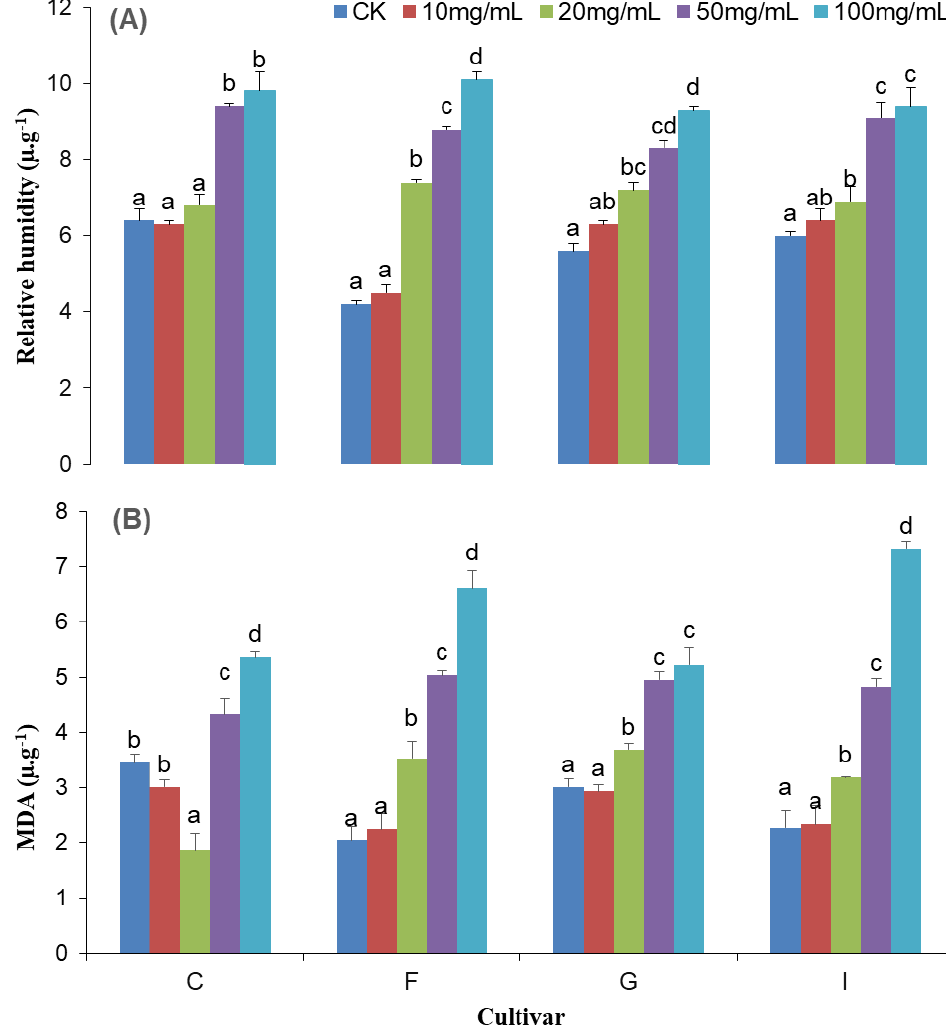
Figure 1. Relative conductivity ( A ) and MDA contents ( B ) of chrysanthemum cultivars subjected to different Cd concentrations. Each value represents the mean ± S.E from the three independent replicates (±, n = 3), and different statistical letters represent significant differences at the p < 0.05 level.